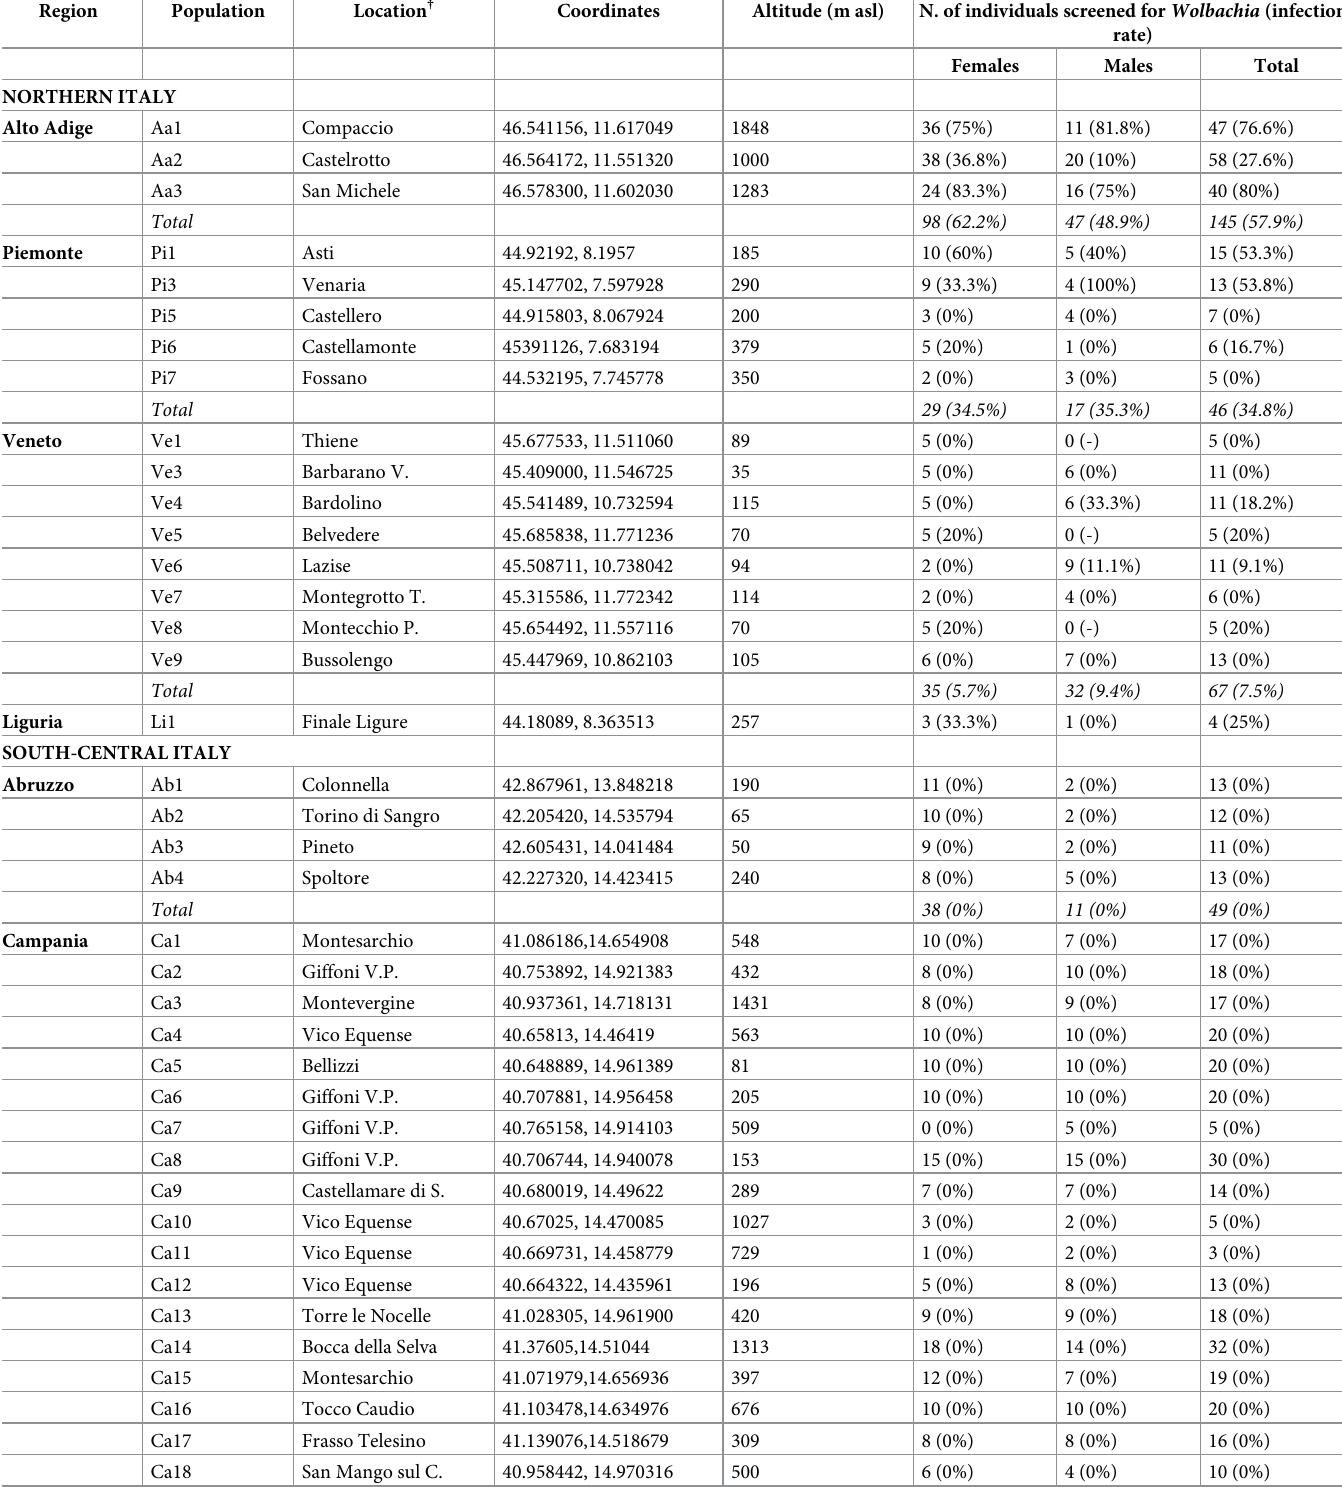
Table 1. Wolbachia infection in Italian populations of Philaenus spumarius .